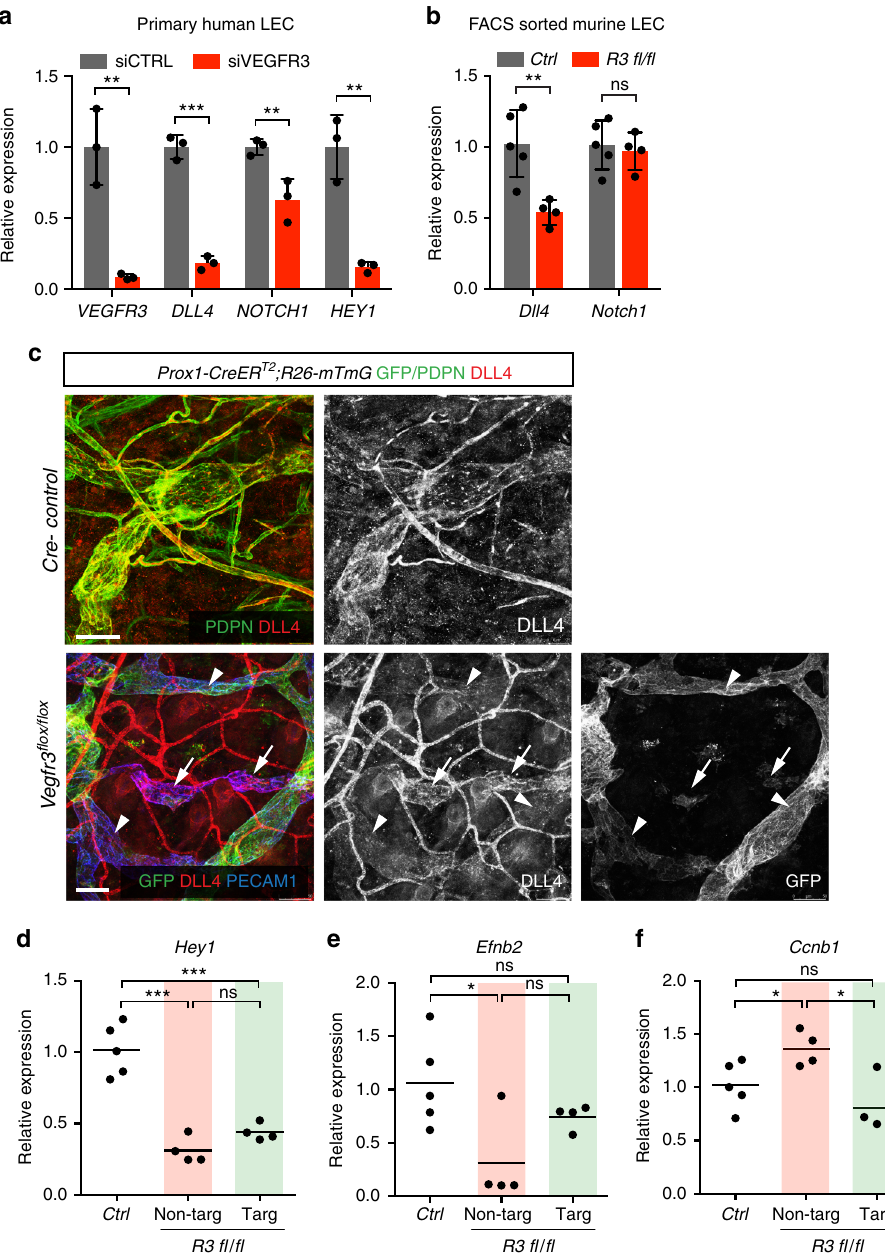
Fig. 6 DLL4 downregulation and decrease in Notch signaling upon loss of VEGFR3. a qRT-PCR analysis of Notch pathway genes in control (siCTRL) and VEGFR3 siRNA (siVEGFR3)-treated human LECs. Bars represent mean relative expression ( n = 3 biological replicates with n = 2 technical replicates each) ± s.d. b qRT-PCR analysis of Dll4 and Notch1 expression in FACS-sorted LECs from P13-P14 Cre − ( Ctrl ) and Vegfr3 fl ox/ fl ox ; R26-mTmG ; Prox1-CreER T2 ( R3 fl / fl ) mice. Tamoxifen (150 µ g) was administered at P2, P4, and P6. Bars represent mean relative expression ( n = 5 Ctrl and n = 4 R3 fl / fl mice) ± s.d. c Whole- mount immuno fl uorescence of ear skin of 3 weeks old Vegfr3 fl ox/ fl ox ; R26-mTmG ; Prox1-CreER T2 and Cre-negative littermate mice treated with Tamoxifen at P2, P4, and P6. Note downregulation of DLL4 protein in targeted GFP + LECs (arrows) compared to non-targeted GFP − LECs (arrowhead) in the mutant ( fl ox/ fl ox ) ear. d Hey1 , ( e ) Efnb2 and ( f ) Ccnb1 expression analyzed by qRT-PCR in FACS-sorted LECs from P13-P14 Cre − ( Ctrl ) and Vegfr3 fl ox/ fl ox ; R26-mTmG; Prox1-CreER T2 ( R3 fl / fl ) mice. Results from non-targeted (Tomato + GFP − ; red), and targeted (Tomato − GFP + ; green) LECs are displayed separately. Horizontal lines represent mean relative expression ( n = 5 Ctrl and n = 4 R3 fl / fl mice with n = 2 technical replicates for each). * P < 0.05, ** P < 0.01, *** P < 0.001. Two-tailed unpaired Student ’ s t test ( a , b , d – f ). Scale bars: 50 µ m ( c ). ns: not signi fi